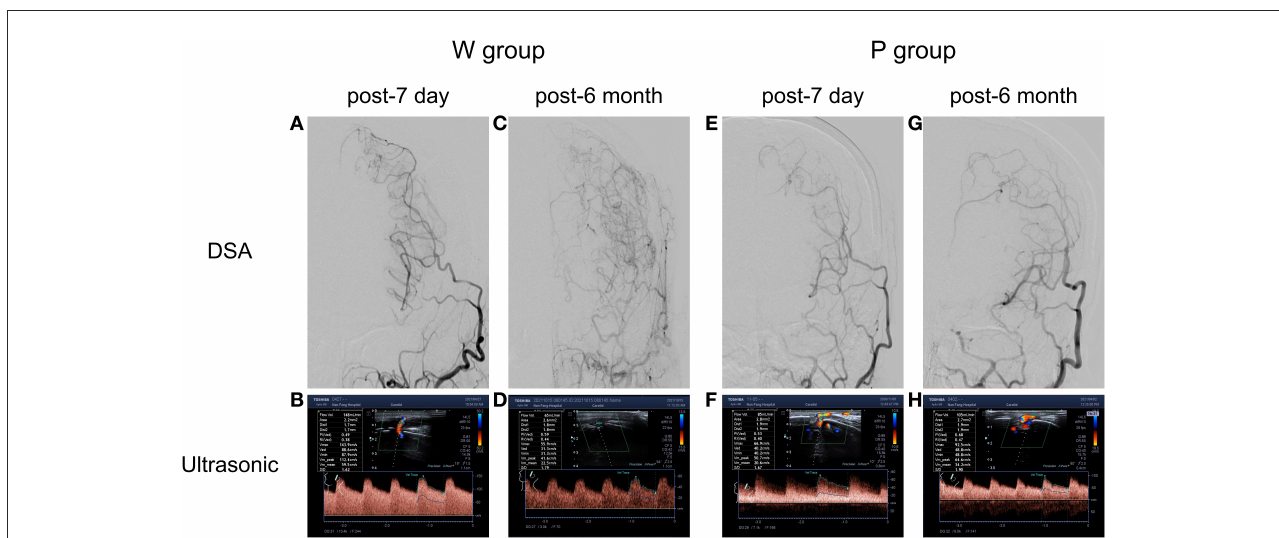
FIGURE1 Typical STA grafts with different groups showed at post-operate 7 day and post-operate 6 month. In well-compensated collateral group (W group), (A) post-operative 7 day DSA showed the patency of grafts, (B) with a high flow rate of 148 ml/min in the ultrasonography examination. (C) Post-operative 6 month DSA confirmed a well-compensated collateral, (D) with a flow rate of 65 ml/min in the ultrasonography examination. In poorly-compensated collateral group (P group), (E) post-operative 7 day DSA showed the patency of grafts, (F) with a high flow rate of 85 ml/min in the ultrasonography examination. (G) Post-operative DSA confirmed a poorly-compensated collateral, (H) with a flow rate of 105 ml/min in the ultrasonography